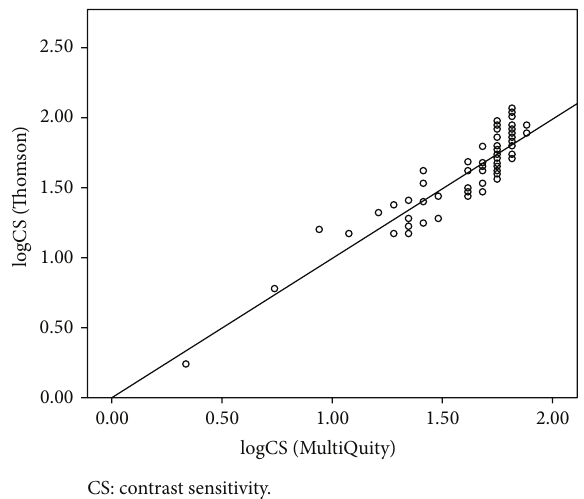
Figure 4: Agreement between log contrast sensitivity from the Thomson device and estimated logCS from the MiQ device. CS: contrast